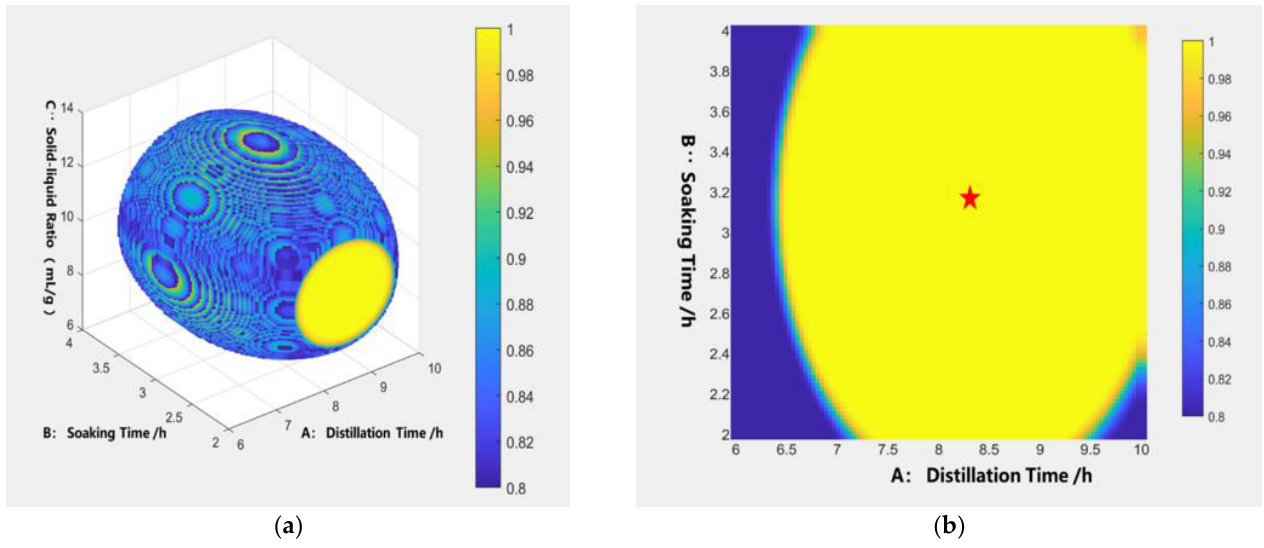
Figure 8. The design space. ( a ) Panorama of the design space. ( b ) The design space when the liquid–material ratio = 9.3:1 (mL·g −1 ). The red star in the figure represents the condition of the verification experiments, and the color bar indicates the probability of the target attainment.